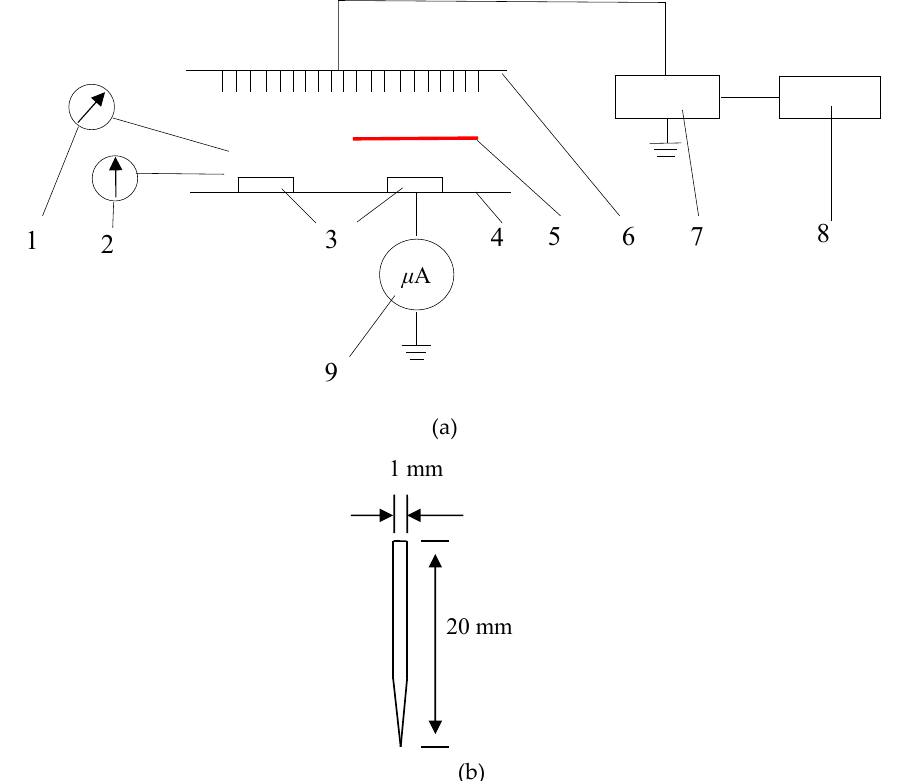
Figure 1. Schematic diagram of electrohydrodynamic (EHD) drying ( a ) and needle electrodes ( b ). 1. Hygrometer; 2. Thermometer; 3. Sample; 4. Ground electrode; 5. Insulating barrier medium; 6. Needle electrode; 7. High voltage power supply; 8. Control system; and 9. Microammeter.